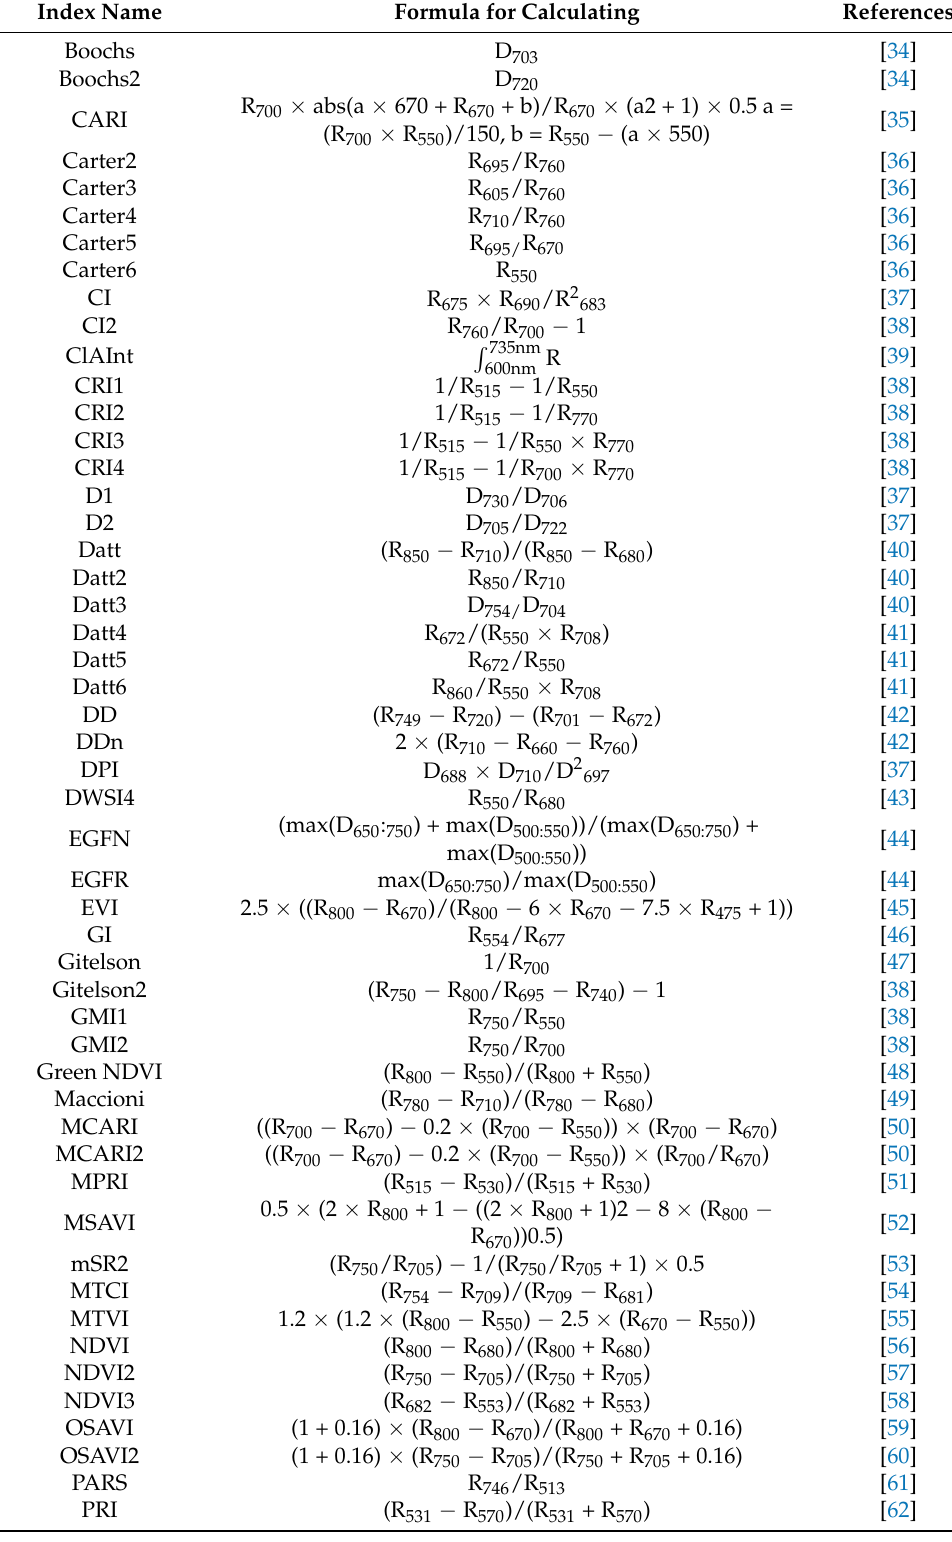
Table 2. VIs tested for their ability to distinguish target weeds of this